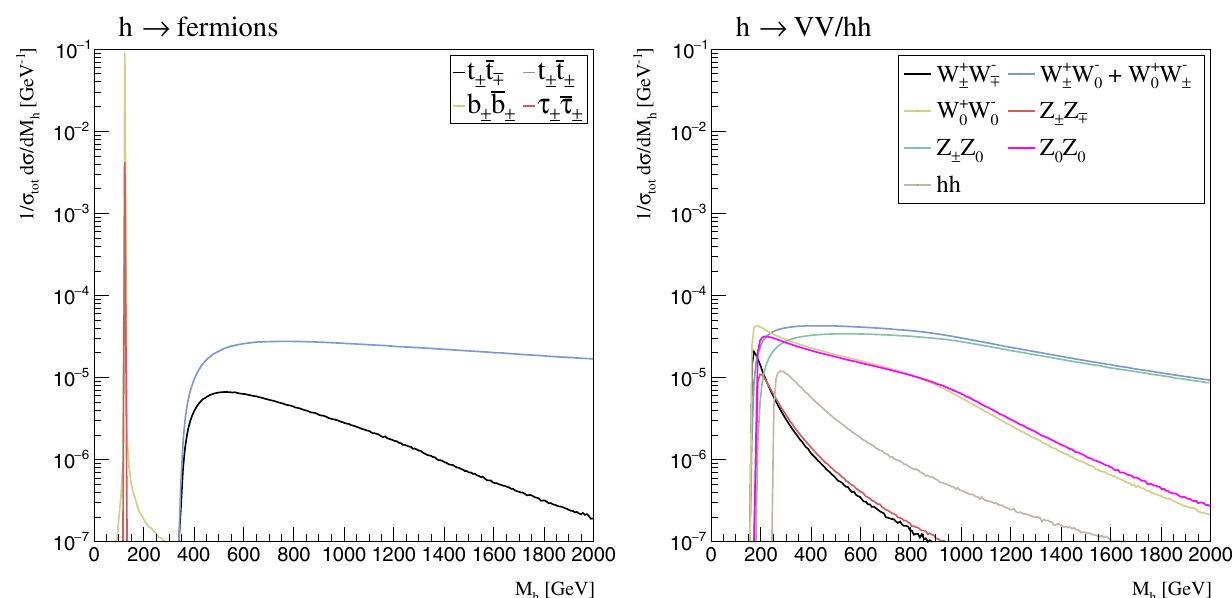
Fig. 4 Branching spectra of a 1 TeV Higgs boson to fermions (left) and V V / hh (right)